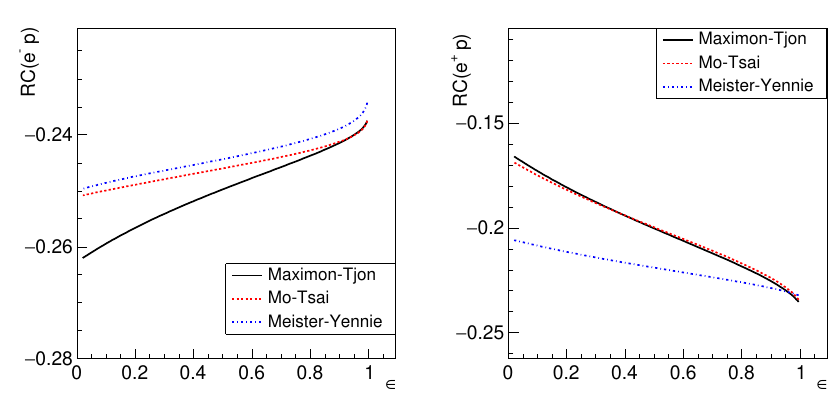
Figure 1. Radiative correction factor as a function of (cid:15) for e − p (left) and e + p (right), from [42] (solid black line), [41] (dashed red line), [44] (dash-dotted blue line) for Q 2 = 1 GeV 2 and ∆ E = 0 . 01 E